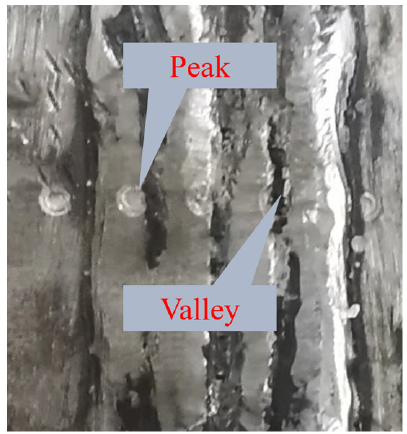
Figure 14. Locations of peak and valley stresses on surface A.